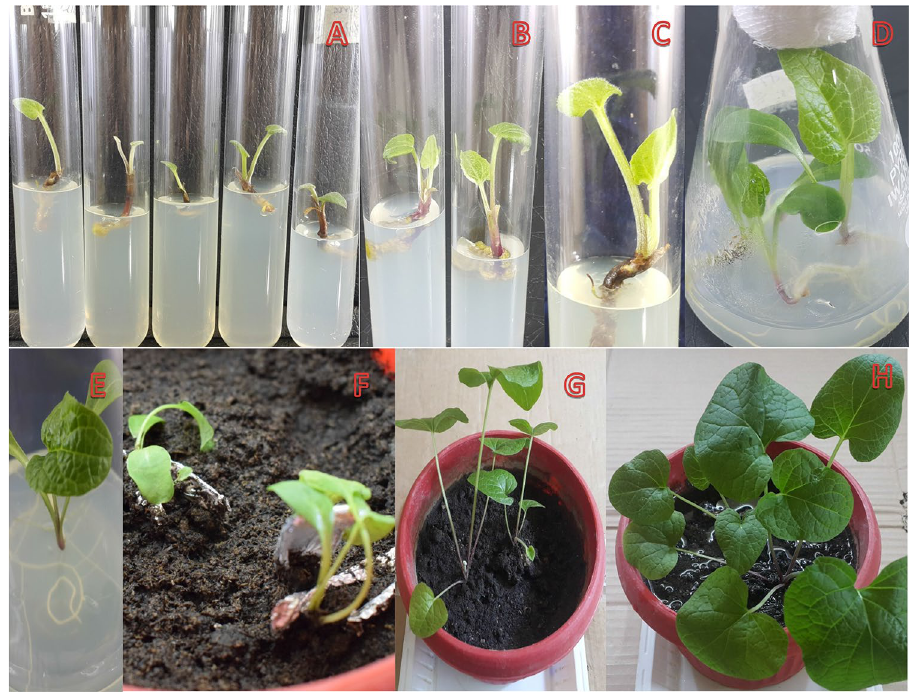
Figure 2. In-vitro Propagation of S. costus using nodal explant ( A ) Auxiliary buds, ( B ) Shoot buds initiation, ( C ) Multiple shoot initiation, ( D , E , F ) Mature plantlets, ( E , F ) Roots initiation, ( G , H ) Acclimatization of plants.